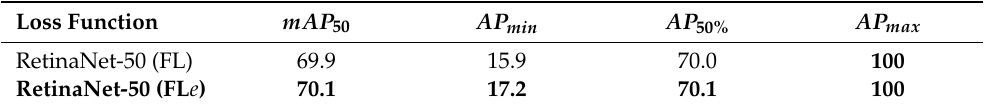
Table 2. Average precision scores on the testing portion of the ARTSv2 dataset. The MAP score indicates the mean of all average precision scores evaluated at an IoU threshold equal to 0.5. We further show average precision scores for the class with the minimum average precision score, the 50th percentile AP score, and the maximum AP score. Loss Function mAP 50 AP min AP 50% AP max RetinaNet-50 (FL) 69.9 15.9 70.0 100 RetinaNet-50 (FL e ) 70.1 17.2 70.1